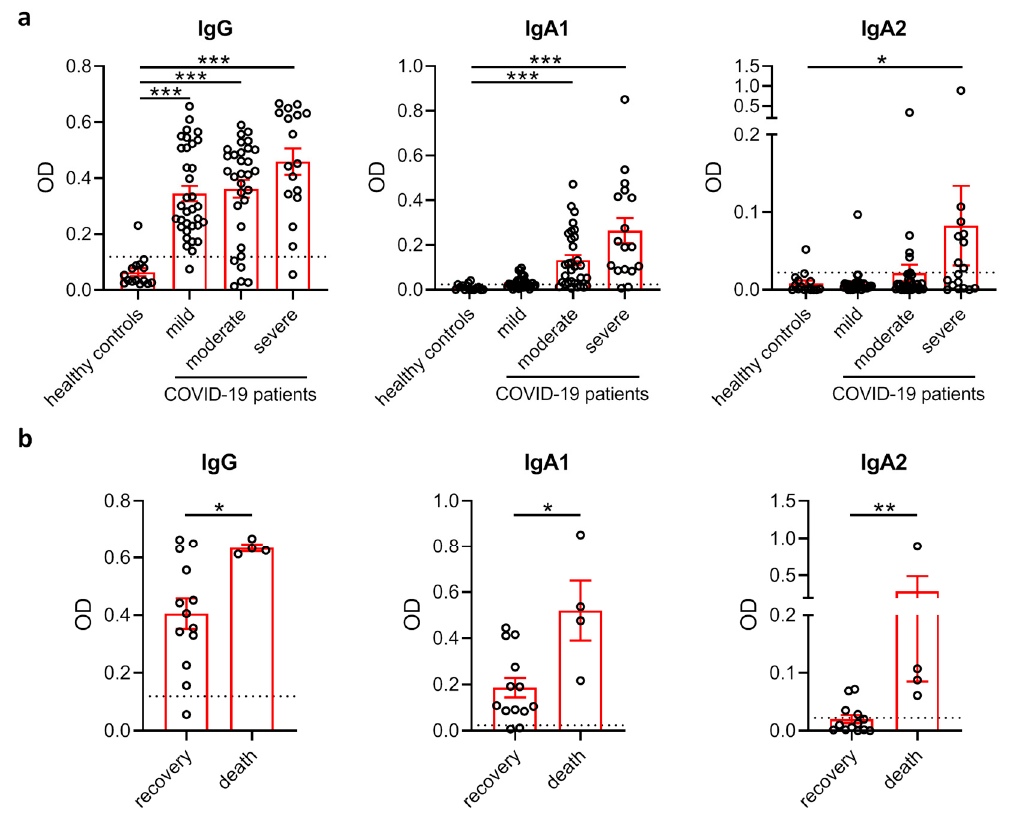
Figure 1. SARS-CoV-2-specific IgA2 levels correlate with disease severity. ( a ) Levels of IgG, IgA1 and IgA2 directed against S1 + S2 protein of SARS-CoV-2 in the plasma of healthy control subjects (N = 15) as well as SARS-CoV-2-infected patients with no or mild disease symptoms (N = 34), moderate symptoms (N = 31) or severe symptoms requiring intensive care treatment (N = 17). Dotted lines represent mean + standard deviation (SD) of the healthy control group. ( b ) Levels of IgG, IgA1 and IgA2 directed against S1 + S2 protein of SARS-CoV-2 in the plasma of COVID-19 patients with severe disease who recovered (N = 13) or died (N = 4). Dotted lines represent mean + SD of the healthy control group from ( a ). Significances were tested with the Kruskal–Wallis test followed by Dunn’s multiple comparison test for all groups vs. the control group ( a ) and a two-sided Mann–Whitney U test ( b ). * p < 0.05; ** p < 0.01; *** p < 0.001. Data are presented as scatter plots with mean ± s.e.m.